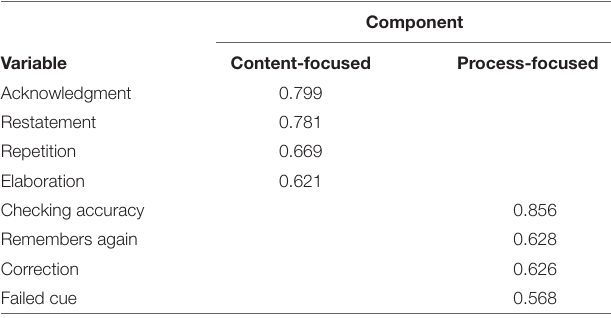
TABLE 2 | Oblimin-rotated pattern matrix from the principal components analysis showing content-focused interaction ( α = 0.72) and process-focused interaction ( α =